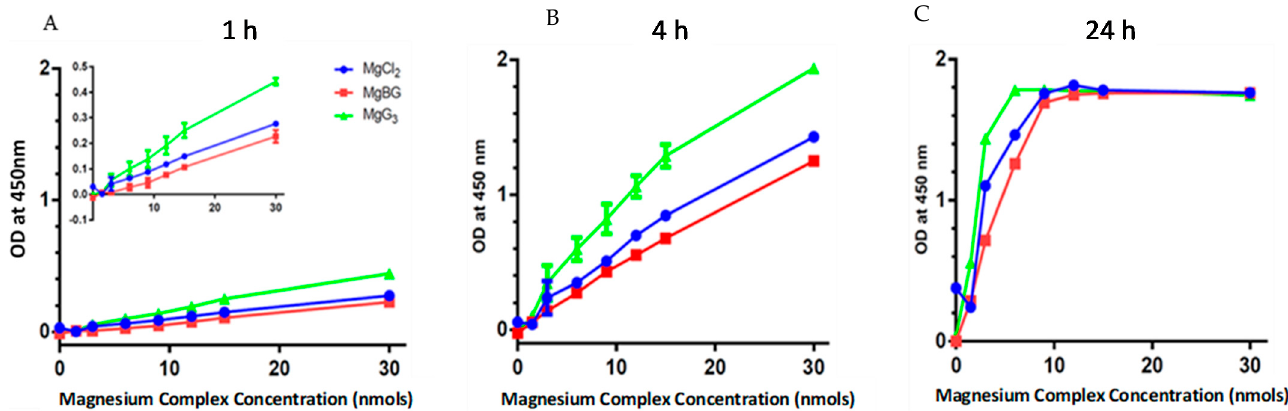
Figure 7. Cellular uptake of MgG 3 ( green: 9% Mg ), MgBG ( red: 14% Mg ), and MgCl 2 ( blue: 25% Mg ) in CaCo-2 cells analyzed at 1 h ( A ): with included expanded inset), 4 h ( B ), and 24 h ( C ). Both 1 and 4 h time points show the increased cellular uptake of MgG 3 relative to MgBG and MgCl 2 , with 24 h showing cell saturation.